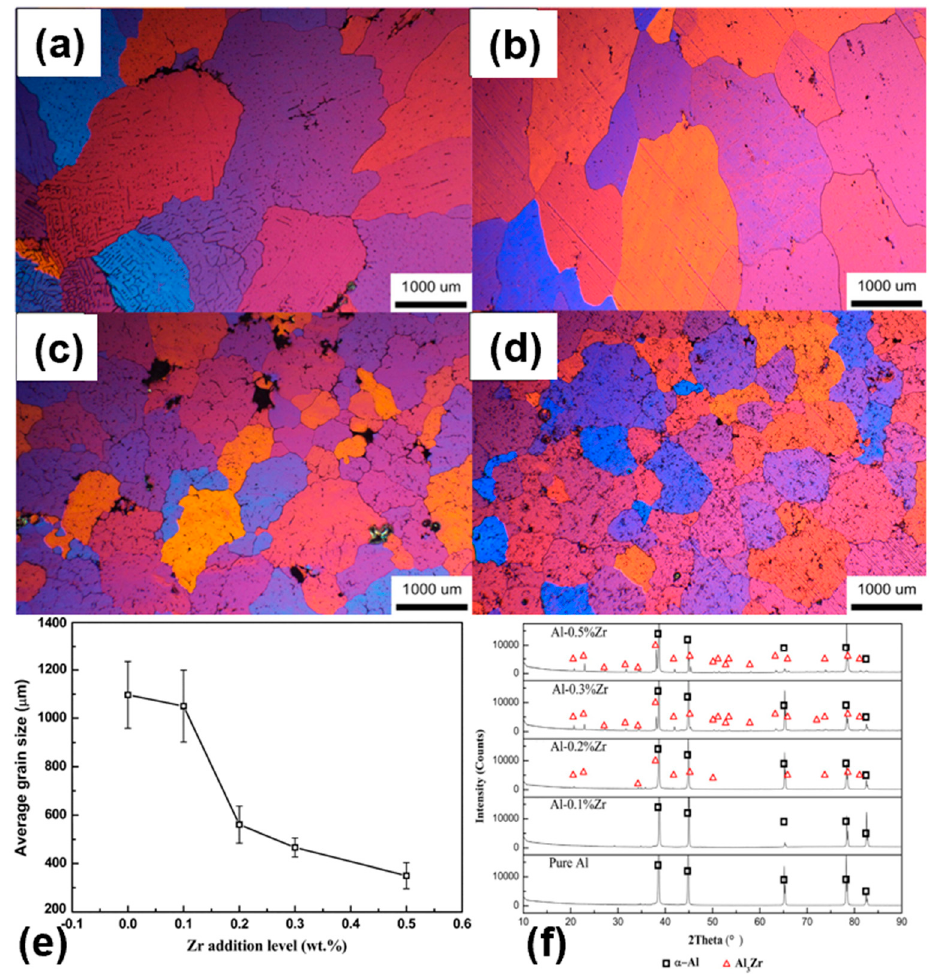
Figure 6. Results of grain refinement [28]: ( a ) 0% Zr, ( b ) 0.1% Zr, ( c ) 0.2% Zr, ( d ) 0.3% Zr, ( e ) relationship of Al grain size and Zr addition level, ( f ) XRD result of as-cast Al. Reprinted with permission from [28], 2013, Elsevier.